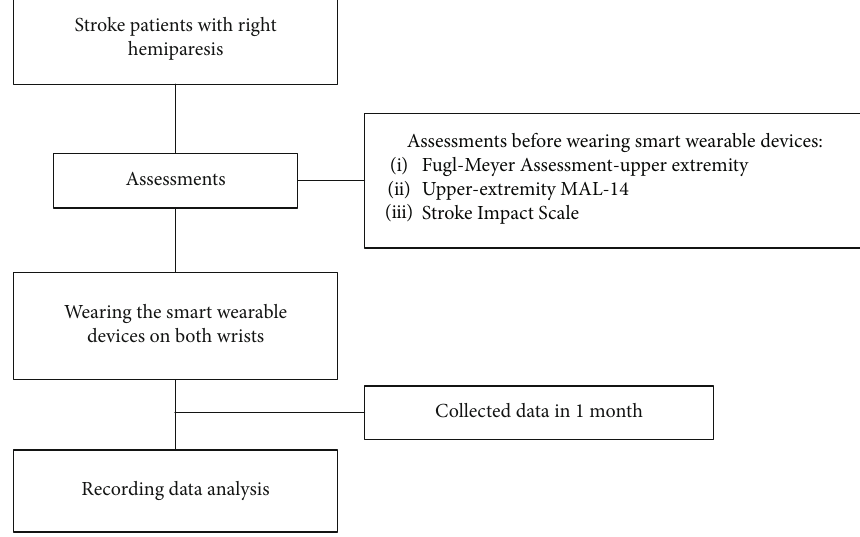
Figure 1: Flowchart for study